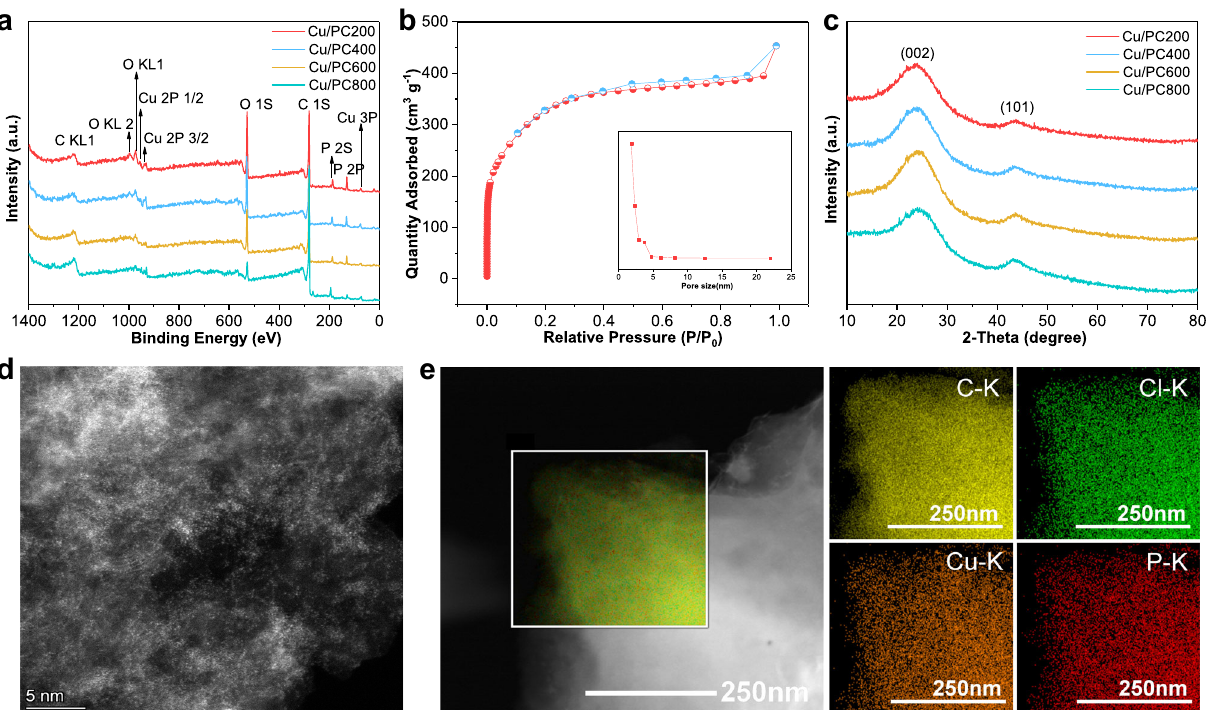
Fig. 1 Characterizations of catalyst materials. a Full XPS spectra of fresh P-doped Cu-based catalysts, b N 2 gas adsorption/desorption isotherms of PC800, c XRD pattern of fresh P-doped Cu-based catalysts, d Representative HAADF-STEM image of fresh Cu/PC800 catalysts. Representative HAADF- STEM image showing isolated Cu species, e EDS elemental mapping of fresh